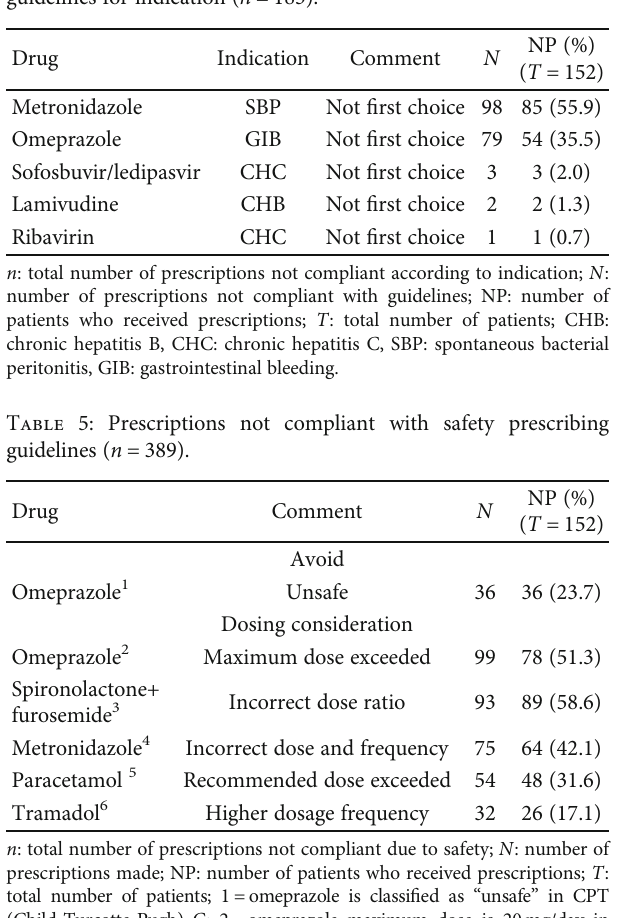
Table 3: Top ten classes of medicines prescribed for patients with liver cirrhosis ( n = 1796 ).